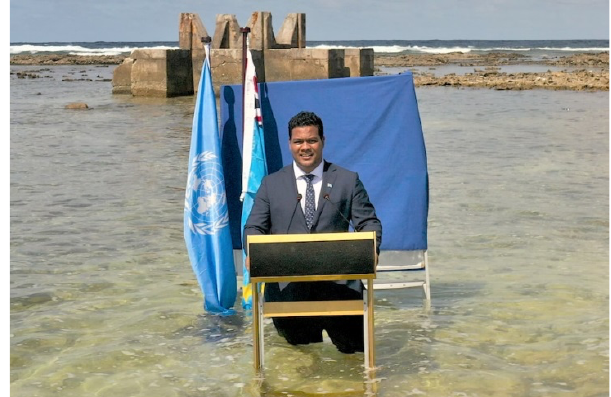
Figure 1: Tuvalu’s Foreign Minister Kofe at COP27 As Mr. Kofe virtually addressed world leaders [figure 1] , the camera zoomed out to reveal Kofe standing in Teafualiku, the